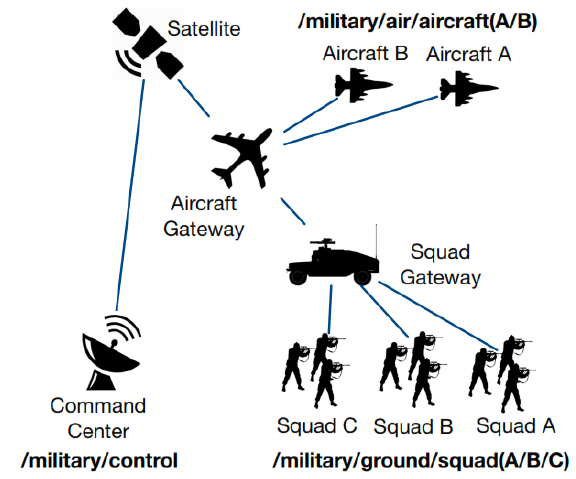
Figure 1. NDN operational scenario